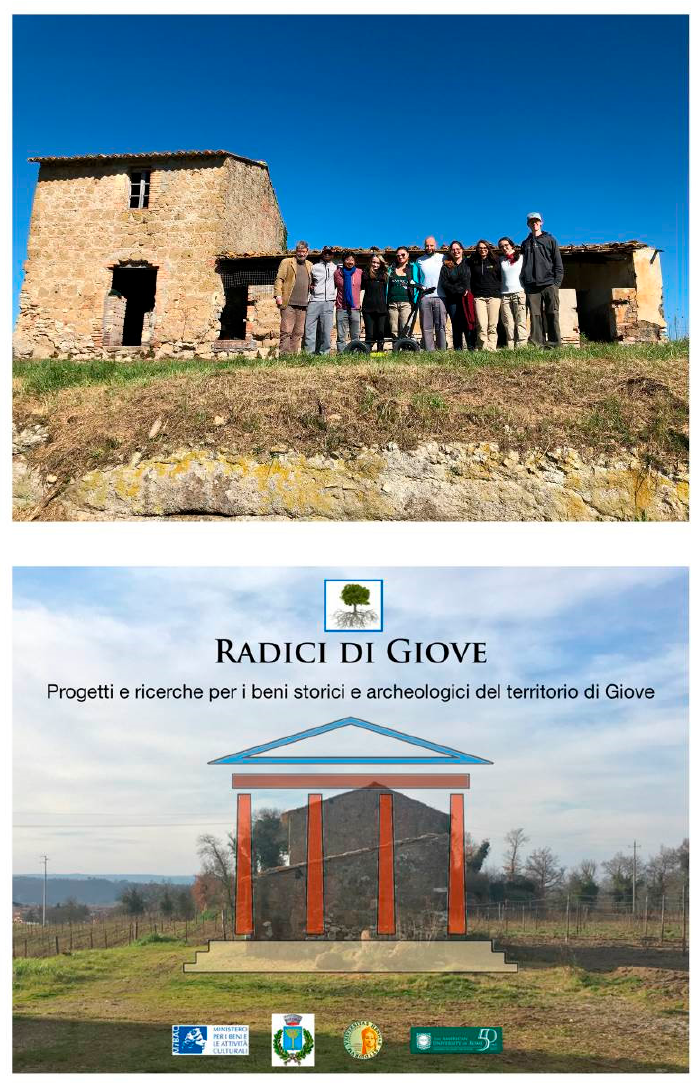
Figure 12. The academic team involved (above) and the research advertisement